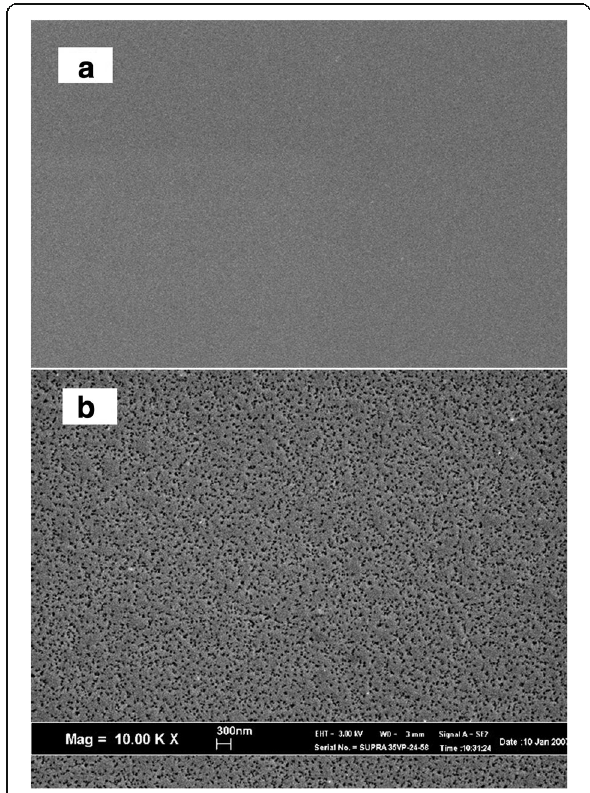
Fig. 1 SEM images of a the pre-cleaned Si wafer and b the Si wafer